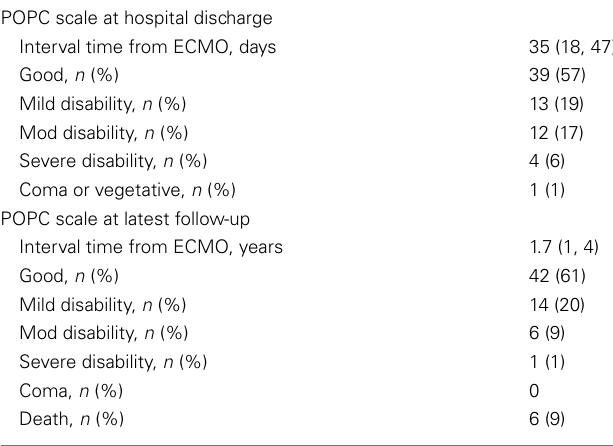
Table 6 | Neurodevelopmental outcomes.